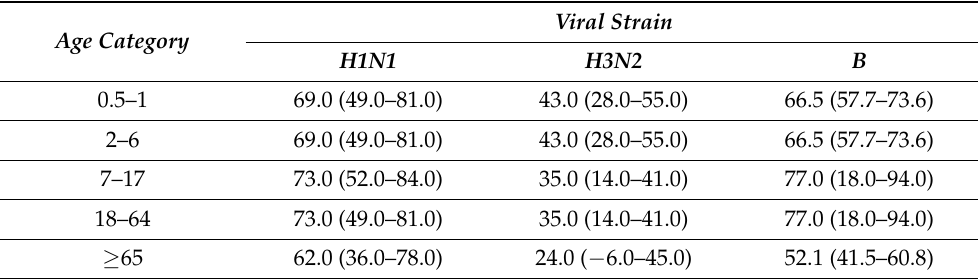
Table 4. QIVe absolute vaccine effectiveness.